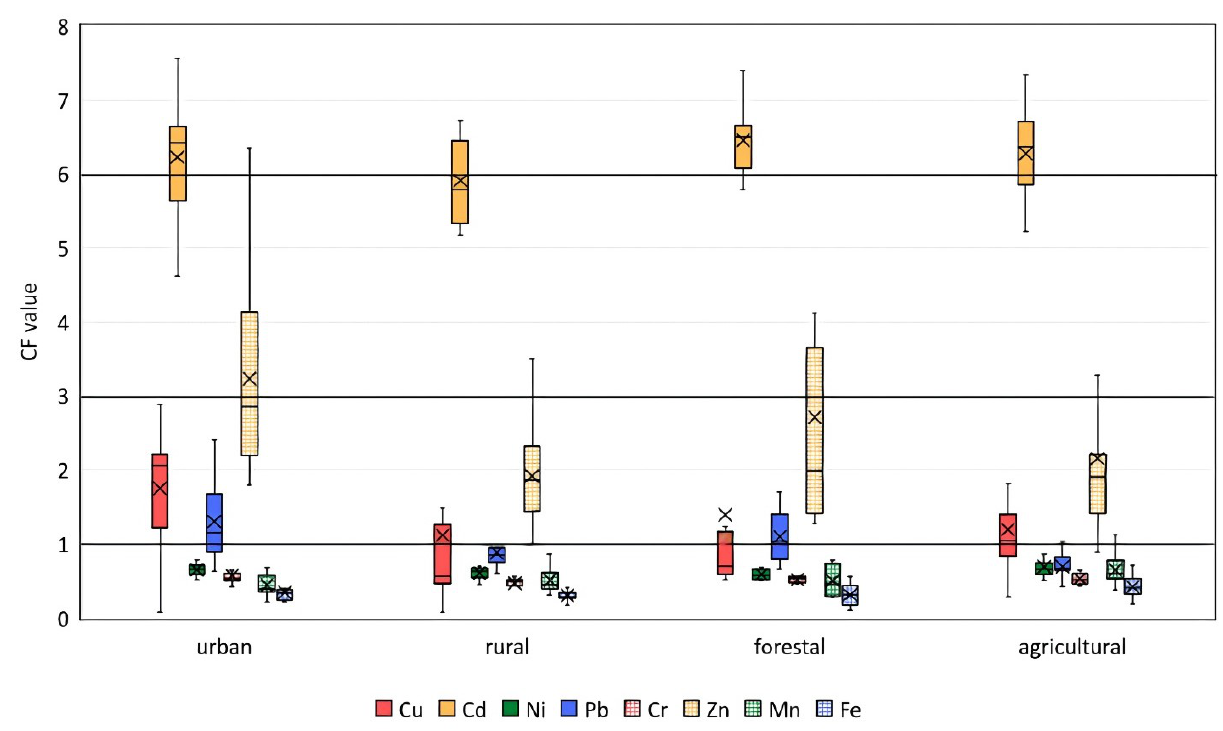
Figure 3. Box plot for CF of heavy metals in roadside soil. The PLI detects the deterioration of soil quality due to heavy metal contamination.